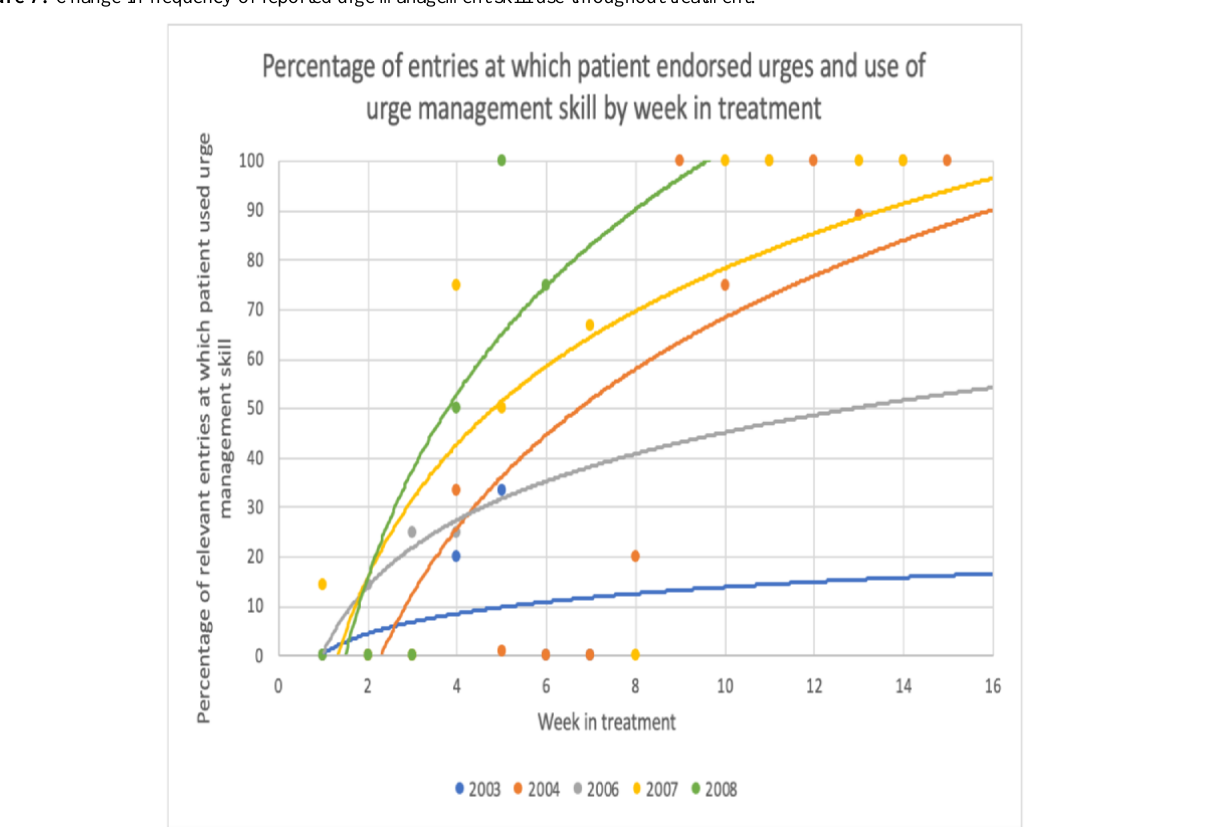
Figure 7. Change in frequency of reported urge management skill use throughout